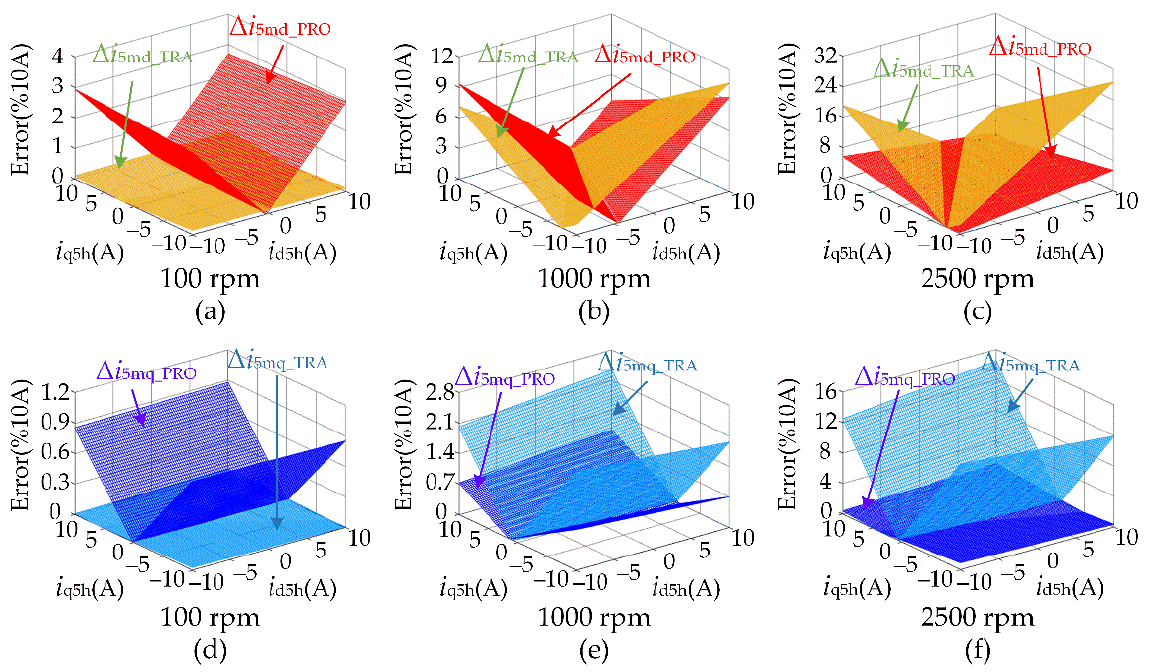
Figure 9. Errors of free components of DPC model and IDPC model at different motor speeds. ( a ) Free component of d-axis current harmonic at 100 rpm; ( b ) free component of d-axis current har- monic at 1000 rpm; ( c ) free component of d-axis current harmonic at 2500 rpm; ( d ) free component of q-axis current harmonic at 100 rpm; ( e ) free component of q-axis current harmonic at 1000 rpm; and ( f ) free component of q-axis current harmonic at 2500 rpm.